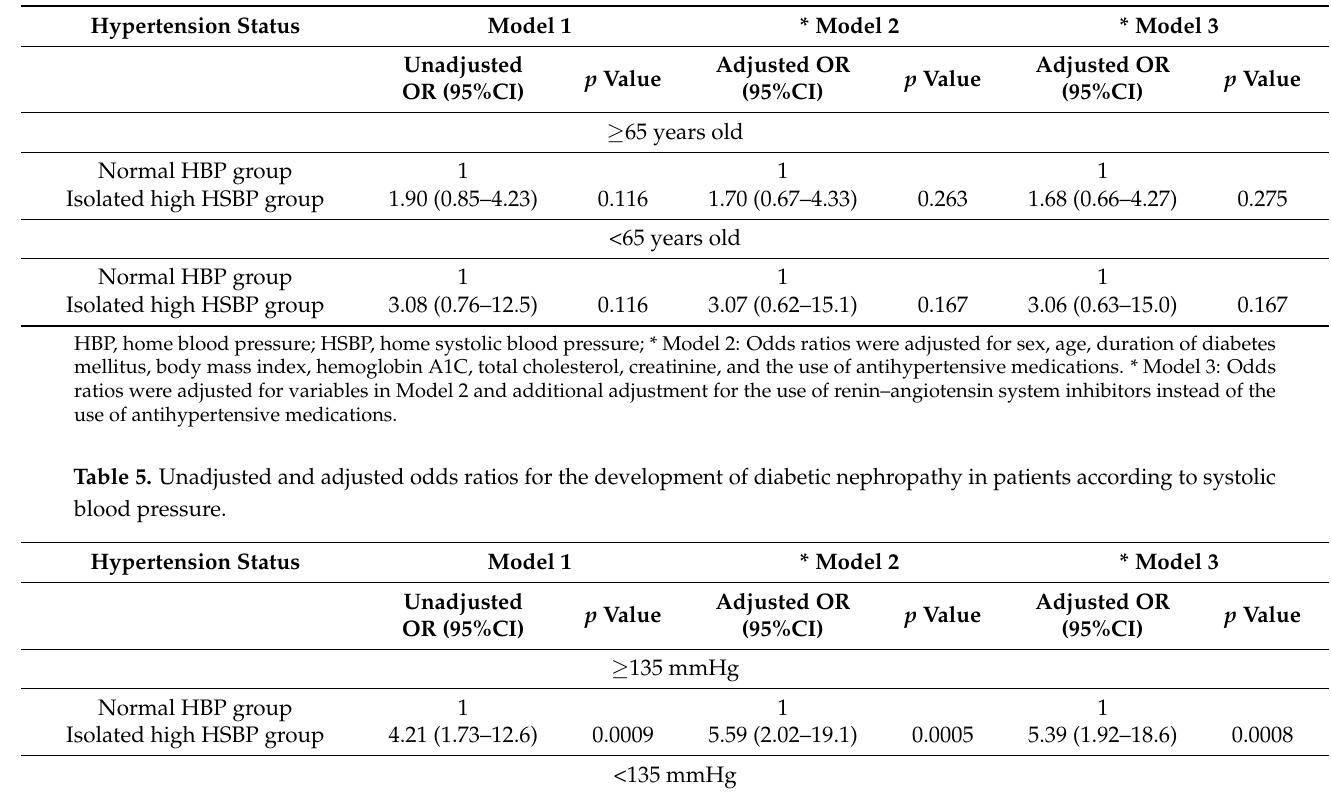
Table 4. Unadjusted and adjusted odds ratios for the development of diabetic nephropathy in patients equal to or more than 65 years old and less than 65 years old.